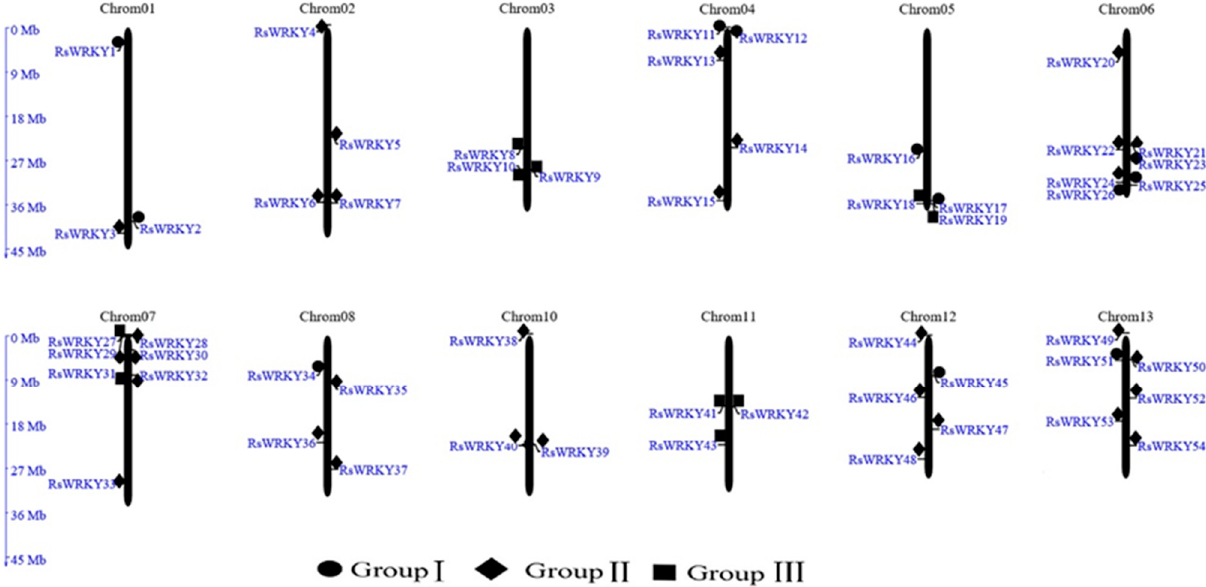
Figure 1. Chromosomal locations of the RsWRKY gene family in R. simsii . The 57 putative WRKY genes were renamed from RsWRKY1 to RsWRK57 according to their chromosomal locations. Three WRKY genes that could not be mapped to any chromosome were named RsWRKY55–RsWRKY57 , respectively.